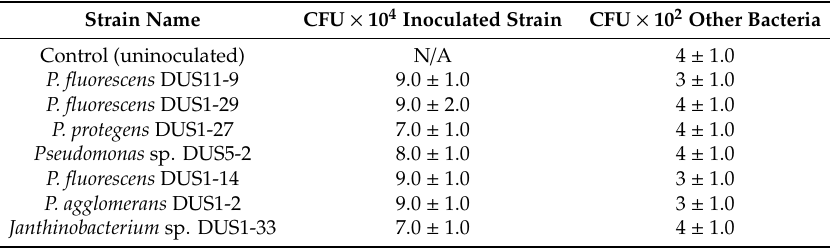
Table 2. Colony forming units (CFU) of inoculated bacteria per g of sand-based medium and CFU per g of “other bacteria” associated with canola grown in sterilised sand-based medium for 30 days with media (soil) maintained at 3% water activity. For each strain, 1 mL of cells (1 × 10 3 ) was applied to seedlings five days post germination. No significant difference ( p < 0.05) was observed for CFU of inoculated strains or “other bacteria” in the sand-based medium after 30 days.